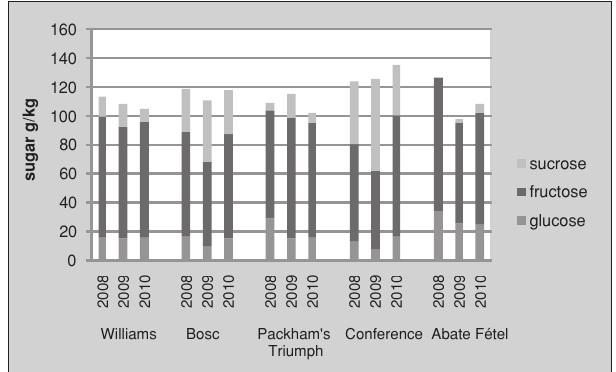
Figure 3: Main sugars of pears